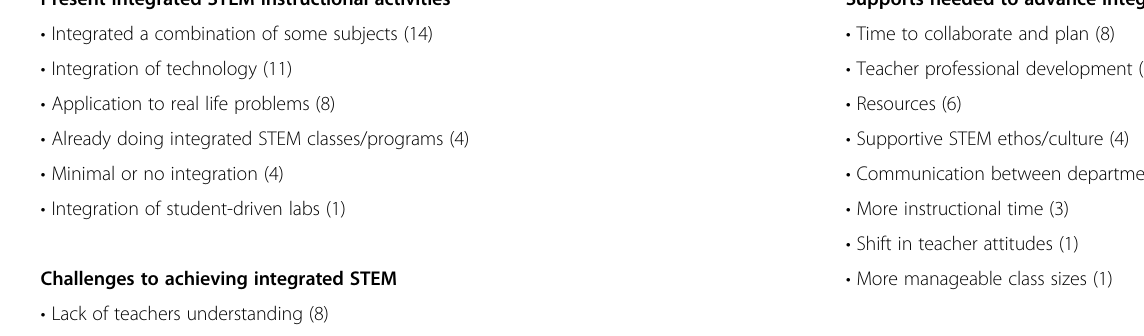
How to improve pre-service education